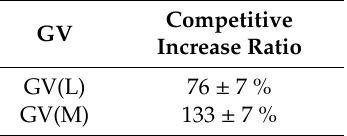
Table 2. Increase ratios of GV(L) and GV(M) under competitive condition. Table 3. Increase ratios of GV(M) and GV(S) under competitive condition. GV